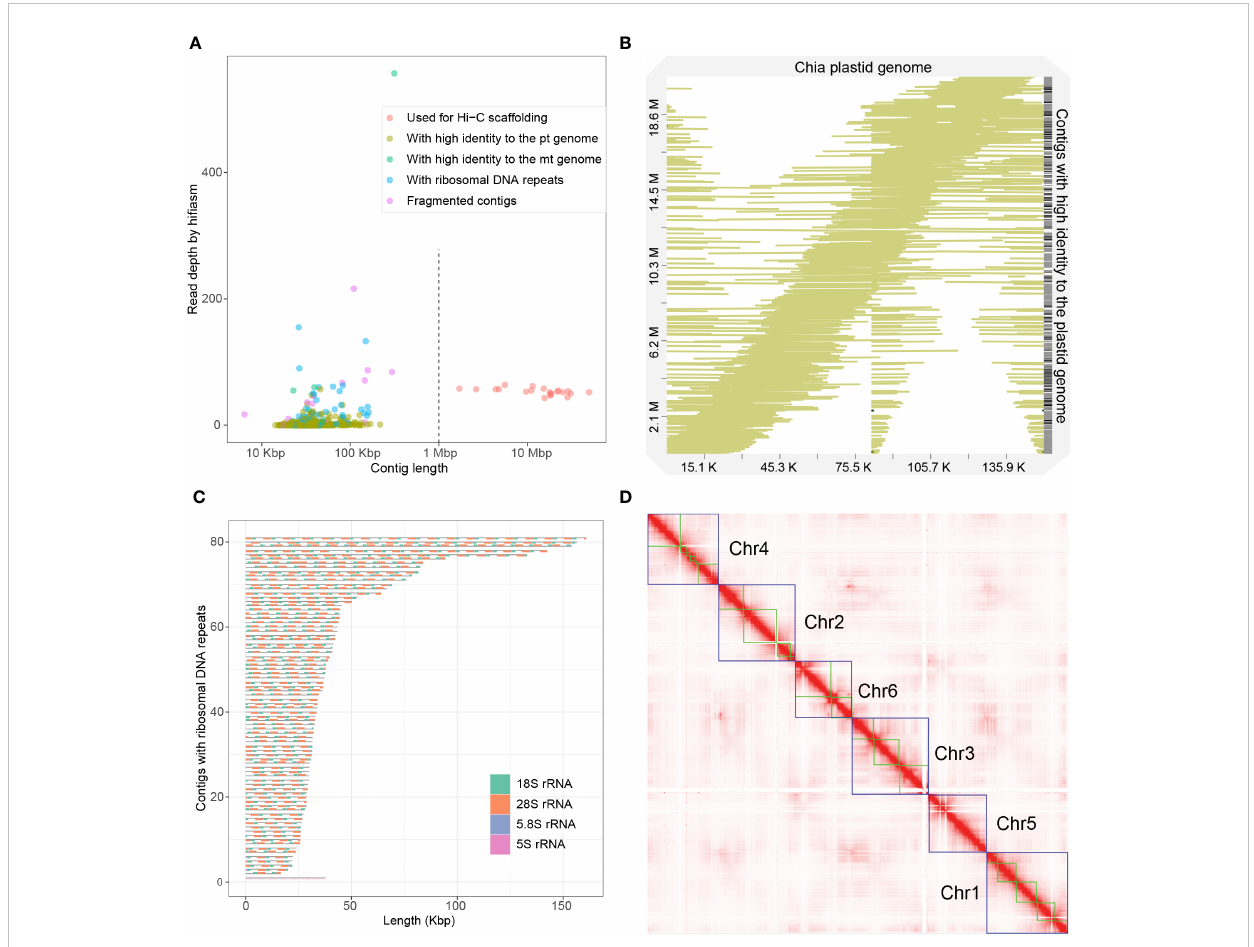
FIGURE 1 Assembly of the chia genome. (A) Dotplot showing the contig length and the read depth of the initial assembly. Contigs were classi fi ed into fi ve categories based on the length, the read depth and their origins, as indicated in the legend. (B) Alignment of 538 initial contigs onto the chia plastid genome. The colored lines indicate the start and the end of the alignment relative to the plastid genome. Numbers in the X-axis indicate the length of the chia plastid genome while numbers in the Y-axis indicate the accumulated length of contigs that show high sequence identity to the plastid genome. (C) Structure of the 81 contigs containing ribosomal RNA repeats. (D) Hi-C contact map of the chia nuclear genome. Blue boxes indicate grouped pseudochromosomes, whereas green boxes indicate